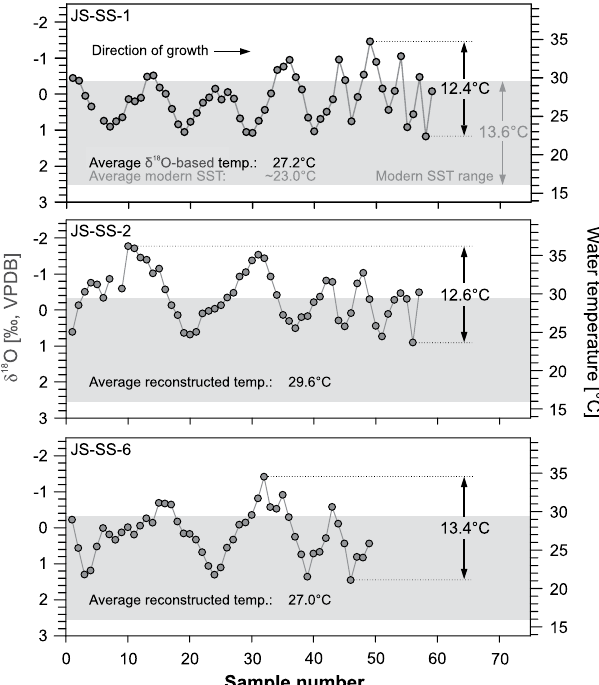
Figure 4. Ontogenetic oxygen-isotope records of three archaeological mid-Holocene Senilia senilis shells and comparison with modern coastal sea surface temperature variability of the eastern Banc d’Arguin 31 . Water temperature reconstruction was done using the equation of Grossman & Ku 30 assuming a δ 18 O Seawater value of + 1.57‰ VSMOW 31 . Error bars for the measured δ 18 O Carbonate values and related water temperature estimates are smaller than the symbol